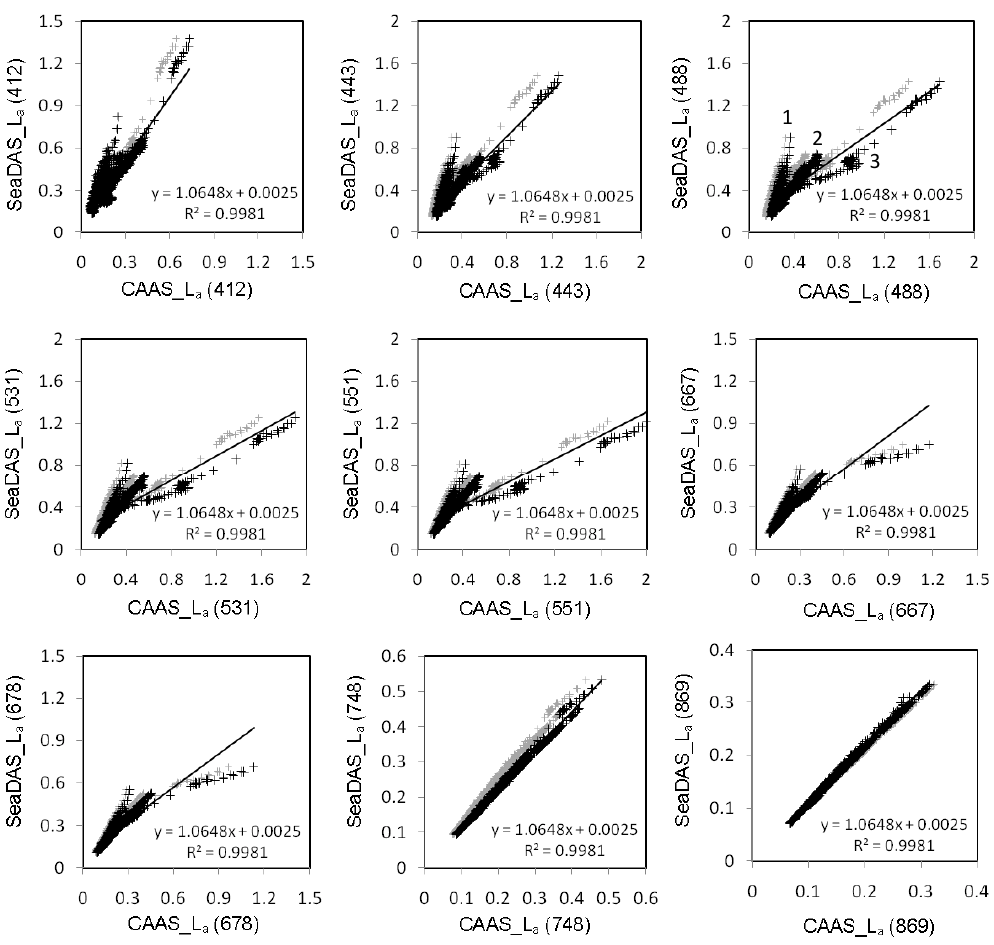
Fig. 6. Scatter plots of the CAAS retrieved L a versus the SeaDAS retrieved L a from MODIS-Aqua imagery (18 February 2010) in bloomed, turbid and relatively clear waters of the Arabian Sea.